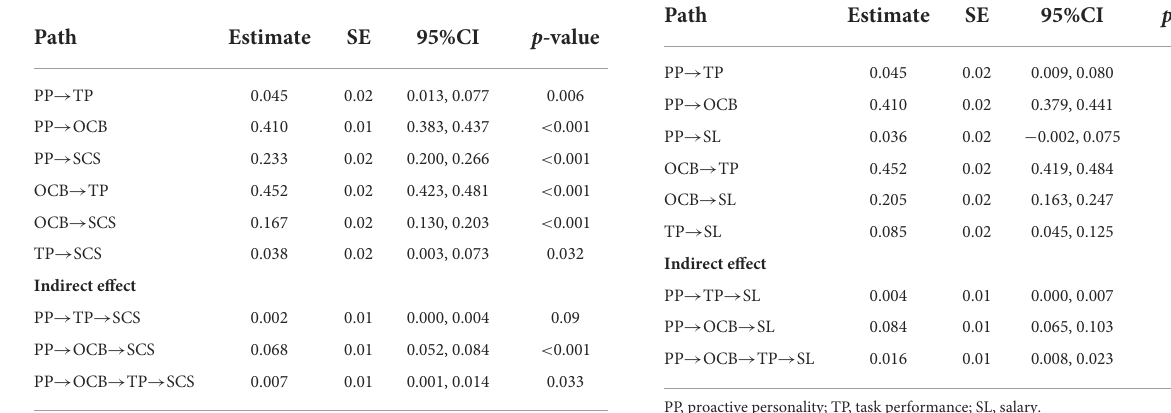
TABLE 2 Path coefficient for proactive personality and subjective career success.